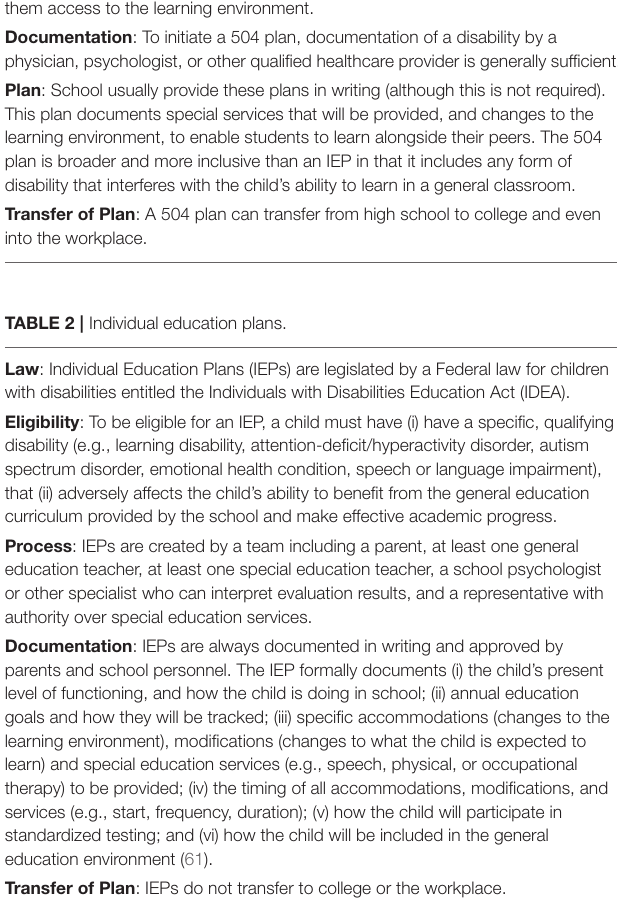
them access to the learning